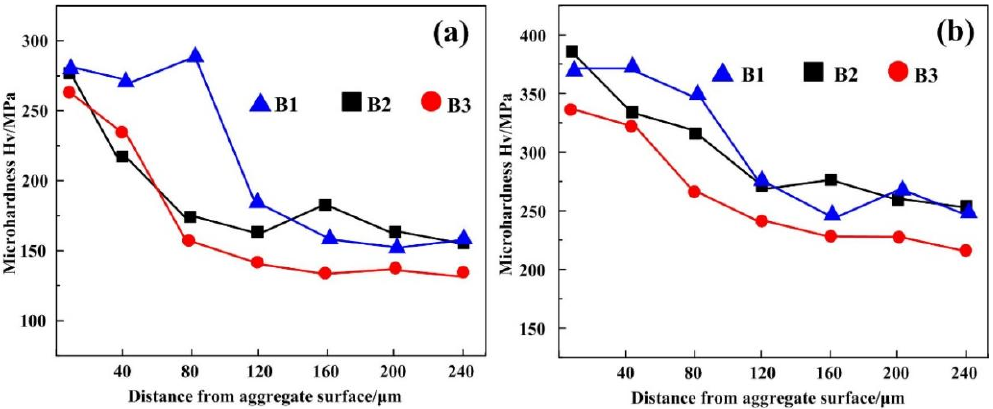
Figure 3. The changes of microhardness of the interface transition zone for specimens B1–B3 after 7 days and 28 days curing times. ( a ) 7 days curing time, ( b ) 28 days curing time.